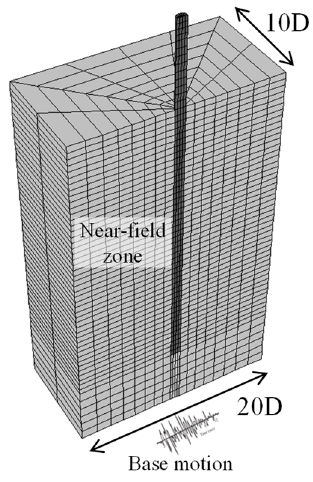
Figure 2. Three-dimensional schematic view of model mesh